Question: What type of chart is this?
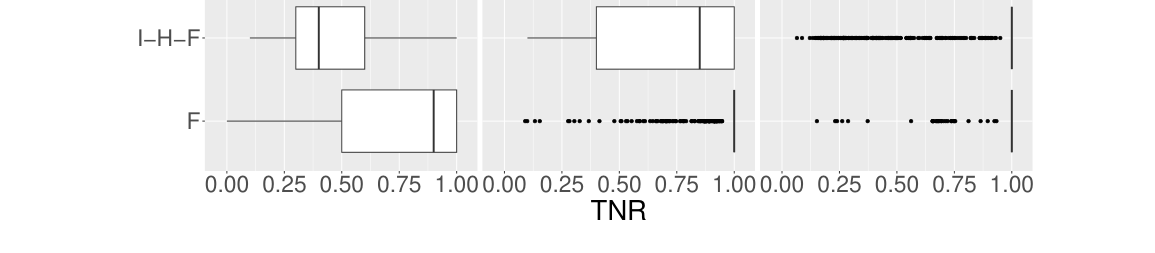
Answer: box